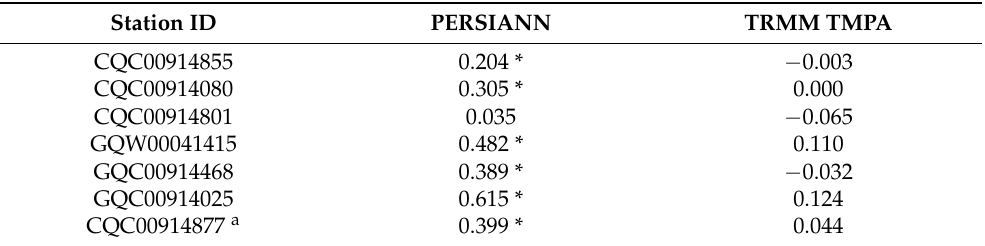
Figure 11. Time series and scatterplots of daily cumulative precipitation for in situ gauges (CQC00914855, CQC00914080, CQC00914801), PERSIANN, and TRMM TMPA during the 2002 Typhoon Chataan. Table 5. R-squared values for daily cumulative rainfall estimates during the 2002 Typhoon Chataan for PERSIANN and TRMM